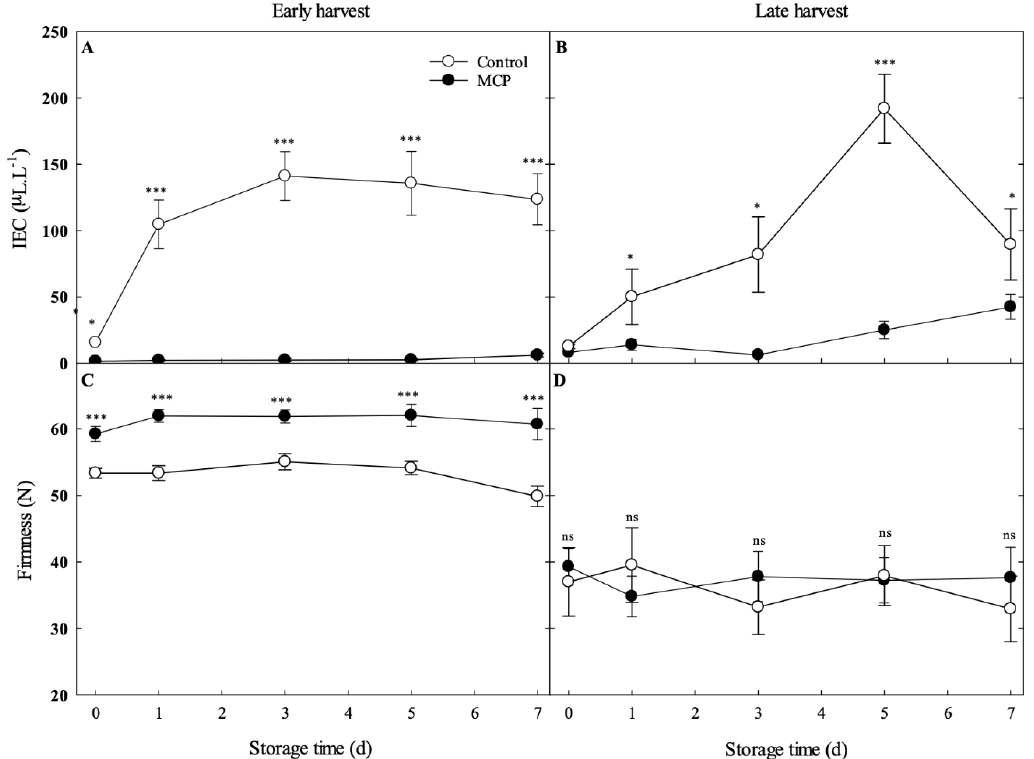
Figure 3. Internal ethylene concentration (IEC) ( A , B ) and flesh firmness ( C , D ) of early and late-harvested ‘Empire’ apples stored at 0.5 °C in air storage up to 7 months and evaluated for 7 days. Bars represent error of the means (SEM; n = 5), when larger than the dimension of the symbol. *, *** Adjacent to each data point for each storage time indicates significant di ff erences as determined by Duncan’s multiple